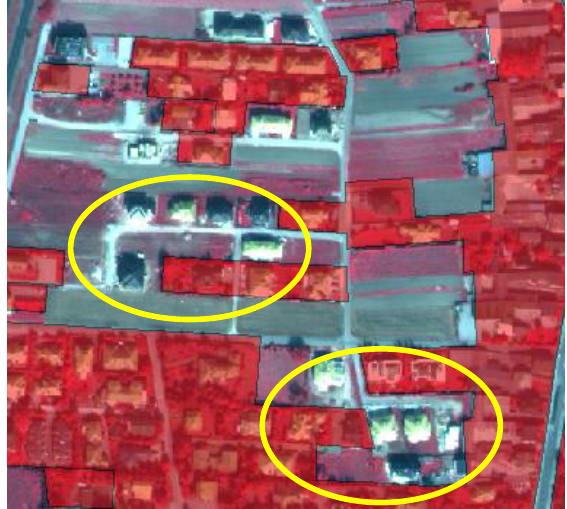
Figure 3. New buildings at residential area (test site “W”) in yellow lines, red patches – build-up area from Topographical